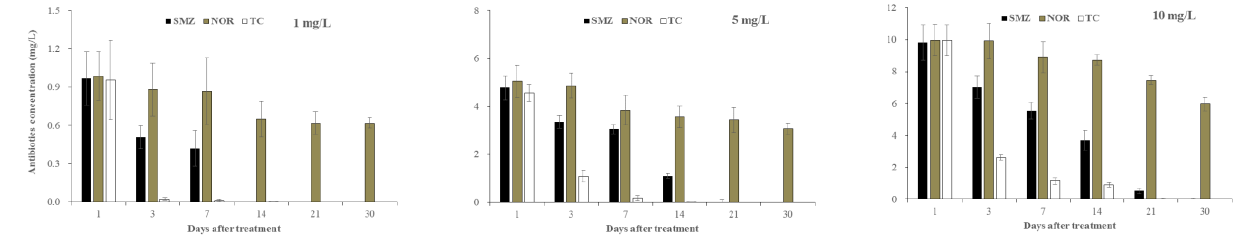
Figure 3. Selected antibiotic concentrations in hydroponic culture solution (water lettuce) under various treatments at the end of the experimental period.